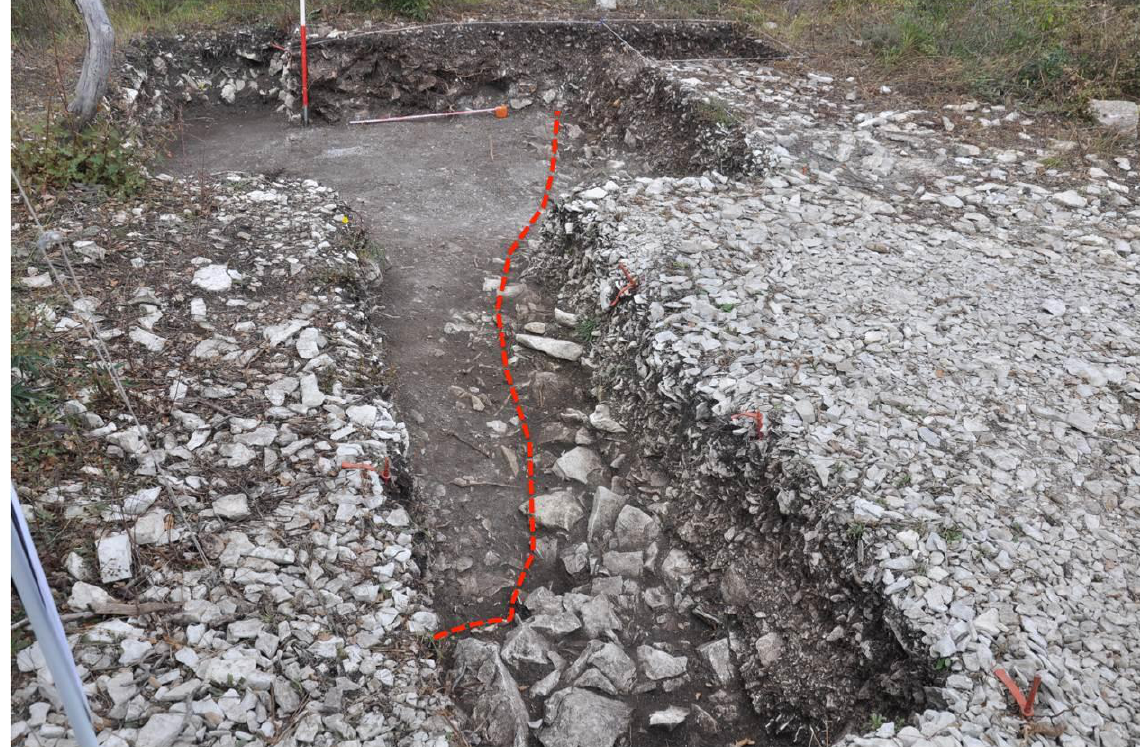
Figure 14. A photo showing the limit of the crescent-shaped dump after the 2013